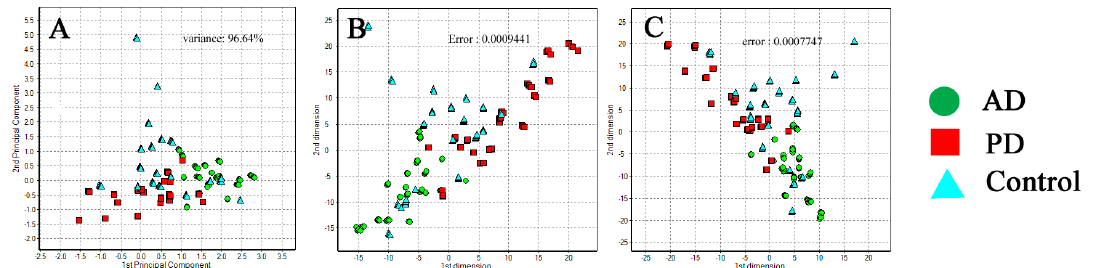
Figure 4. Distribution clusters for exhaled breath samples of Alzheimer’s disease (AD), Parkinson’s disease (PD), and control groups using exhaled breath system A. ( A ) Principal component analysis (PCA) clustering method for AD, PD, and control groups; ( B ) Sammon’s mapping for AD, PD, and control groups; ( C ) Combination of PCA and Sammon’s mapping for patient and control groups.